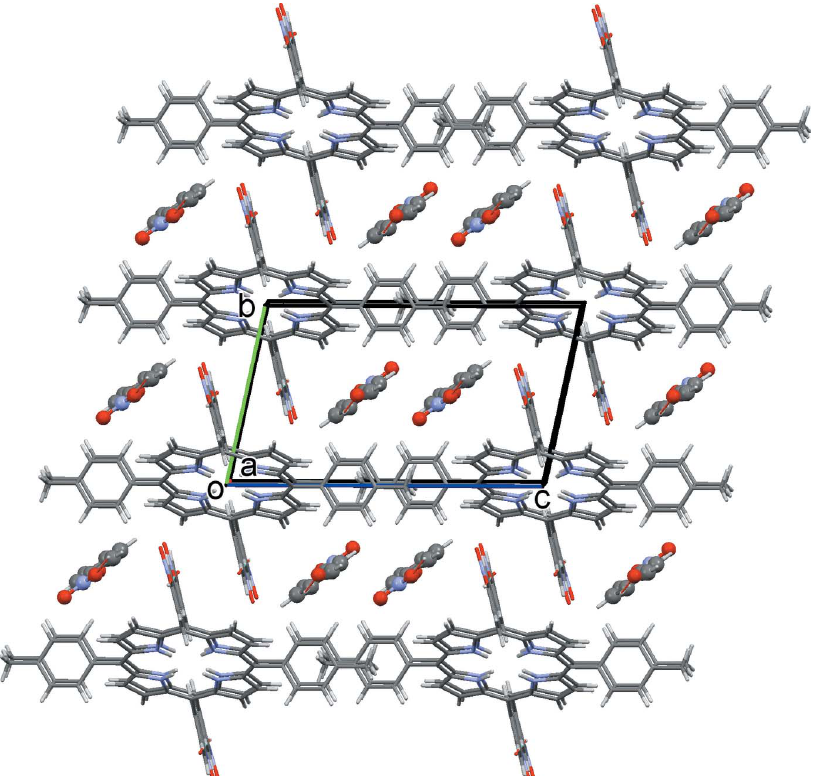
Figure 3 Aview along the a axis of the interlayer stacking in the crystal of the title compound, also showing the intercalation of the nitrobenzene groups between the layers. Table 2 Experimental